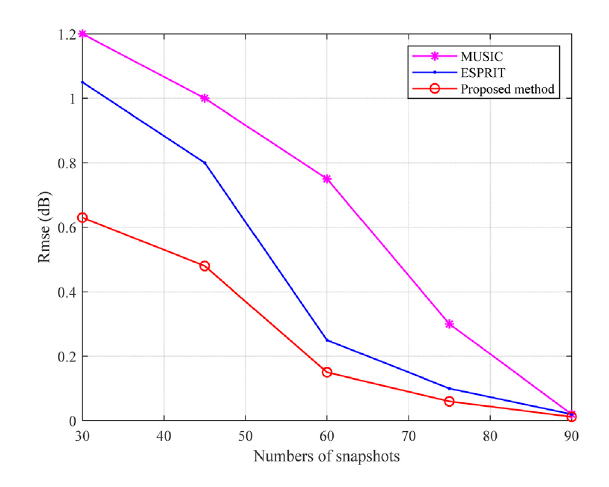
FIGURE 4 DOD estimation performance with different snapshots.